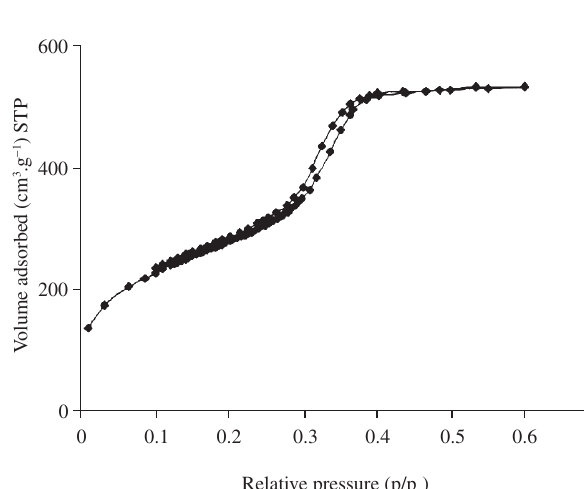
Figure 3. Nitrogen sorption isotherms at 77 K for calcined sample prepared from Tween 80 and Span 80 surfactant mixture.